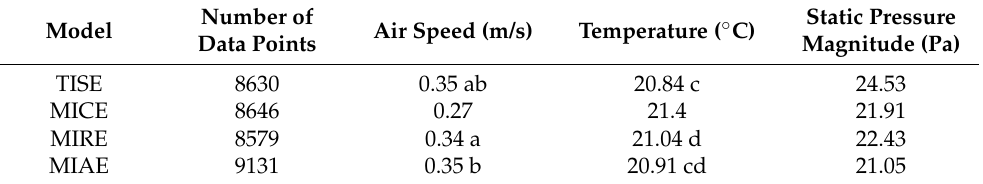
Table 6. Means of environment parameters at Plane N in four models. Note all the differences without annotation are statistically significant (ANOVA and subsequent Tukey’s test, p < 0.01) in this table.